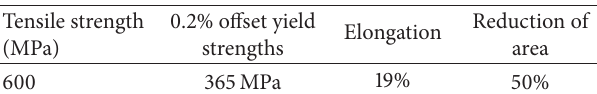
Table 2: Mechanical properties.